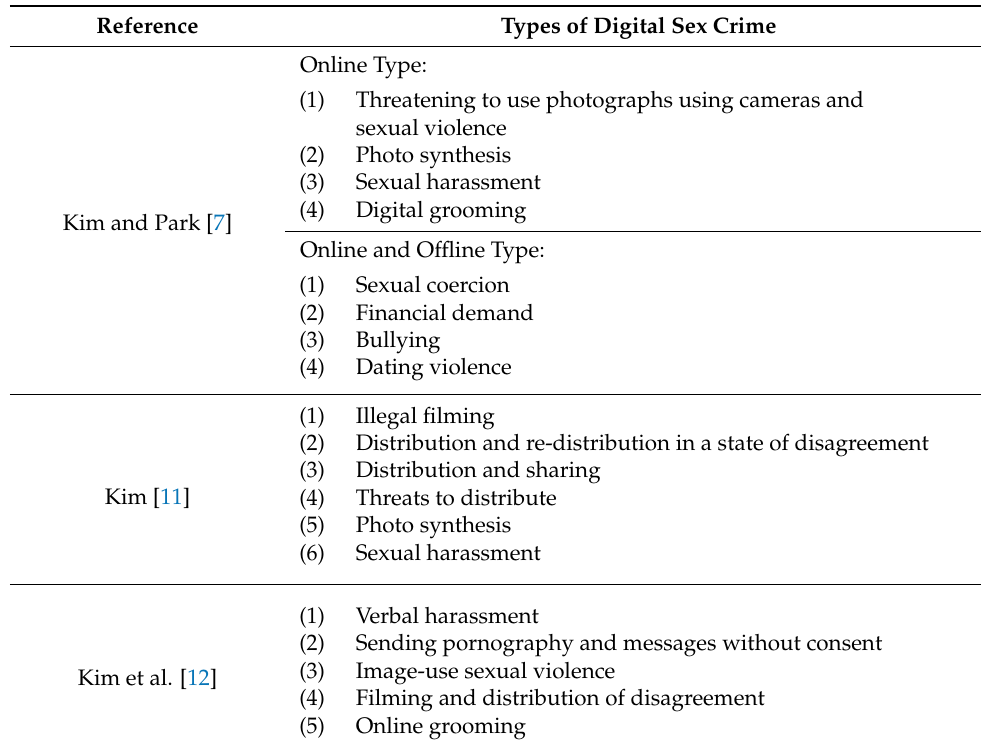
Table 1. Summarization of the Various Types of Digital Sex Crimes.